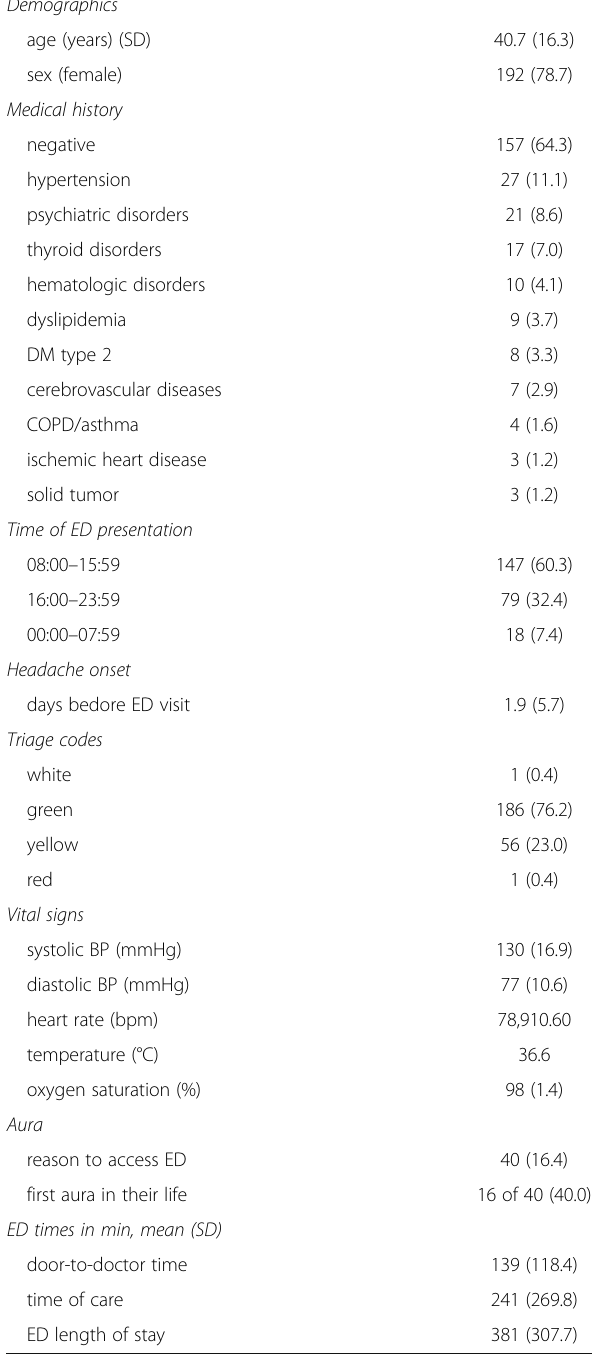
Table 1 Demographic and clinical characteristics of